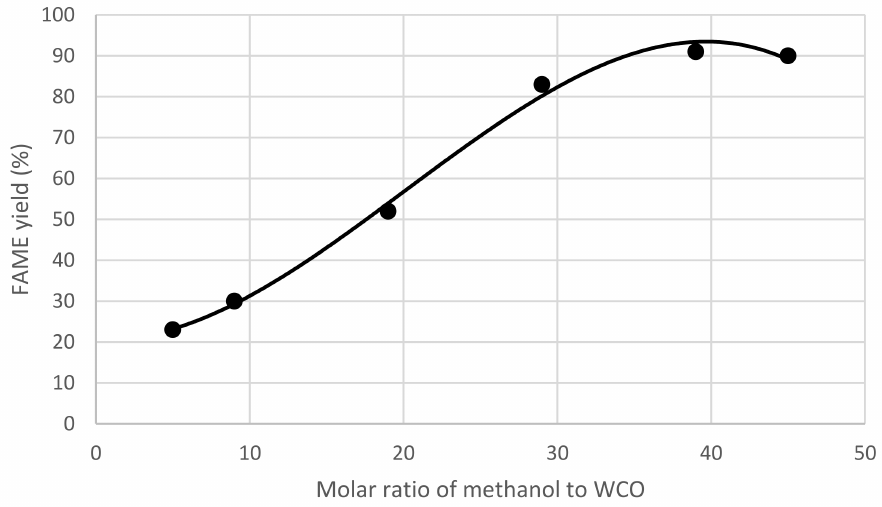
Figure 7. FAME yield (%) at variable molar ratio (P = 351 bar, T = 590 K, Time = 15